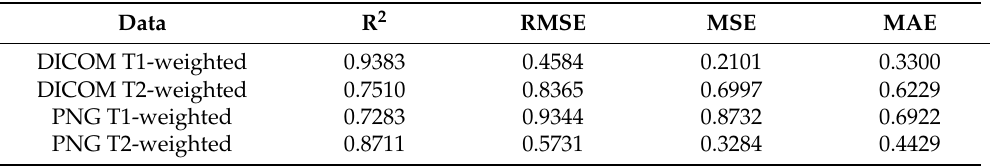
Table 2. Quantitative regression parameters for different types of data and bone images (metric). Results for 3 features derived from 15 by applying principal component